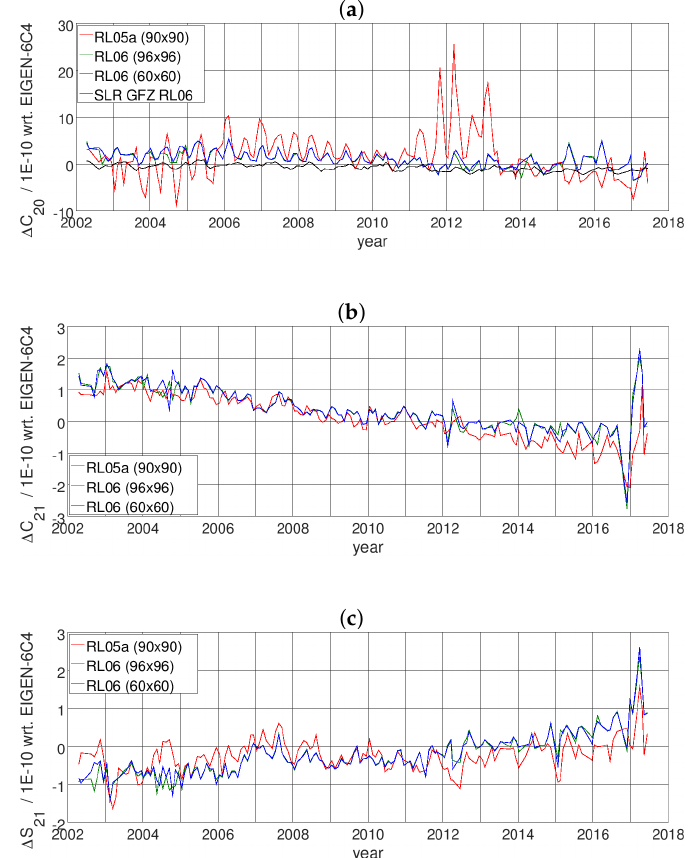
Figure 7. Time series of SH coefficients C 20 ( a ); C 21 ( b ); and S 21 ( c ); each plot shows values of GFZ RL05a (red), GFZ RL06 (96 × 96, green), and GFZ RL06 (60 × 60, blue); for C 20 , the SLR-based time series König et al. [42] is shown additionally